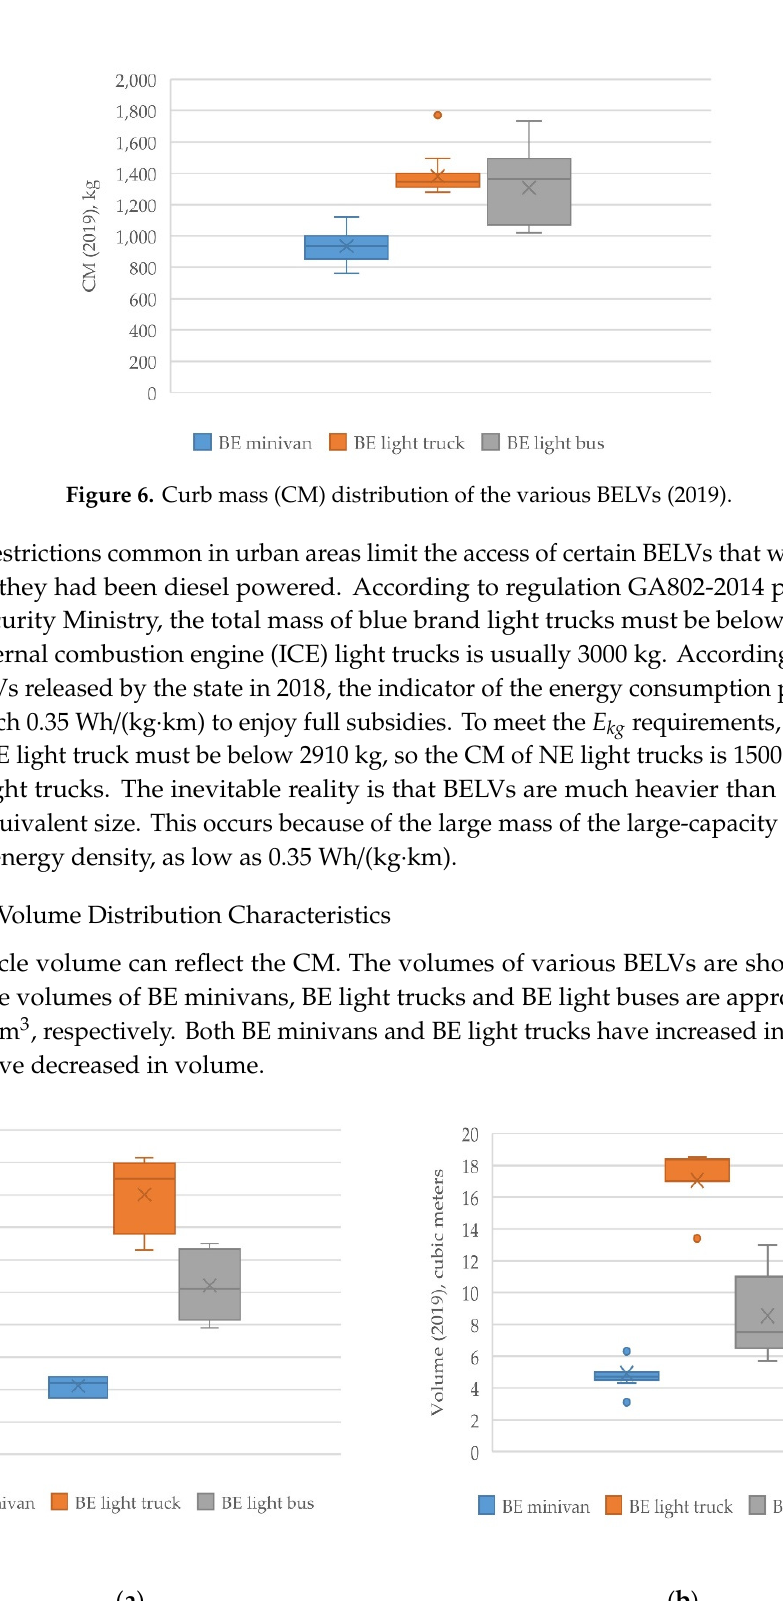
( b ) Figure 8. All-electric range (AER) distribution of the various BELVs, ( a ) 2017 and ( b ) 2019. In addition, due to battery attenuation every year, the actual AER decreases rapidly year by year, which makes it difficult to truly meet the logistics demand [13]. AER anxiety is particularly prominent in intercity logistics. Most of intercity logistics transportation relies on heavy trucks driving on highways, and the daily miles travelled often exceeds 600 km. However, there are currently no BE heavy trucks on the Chinese market with AER of 600 km or more.